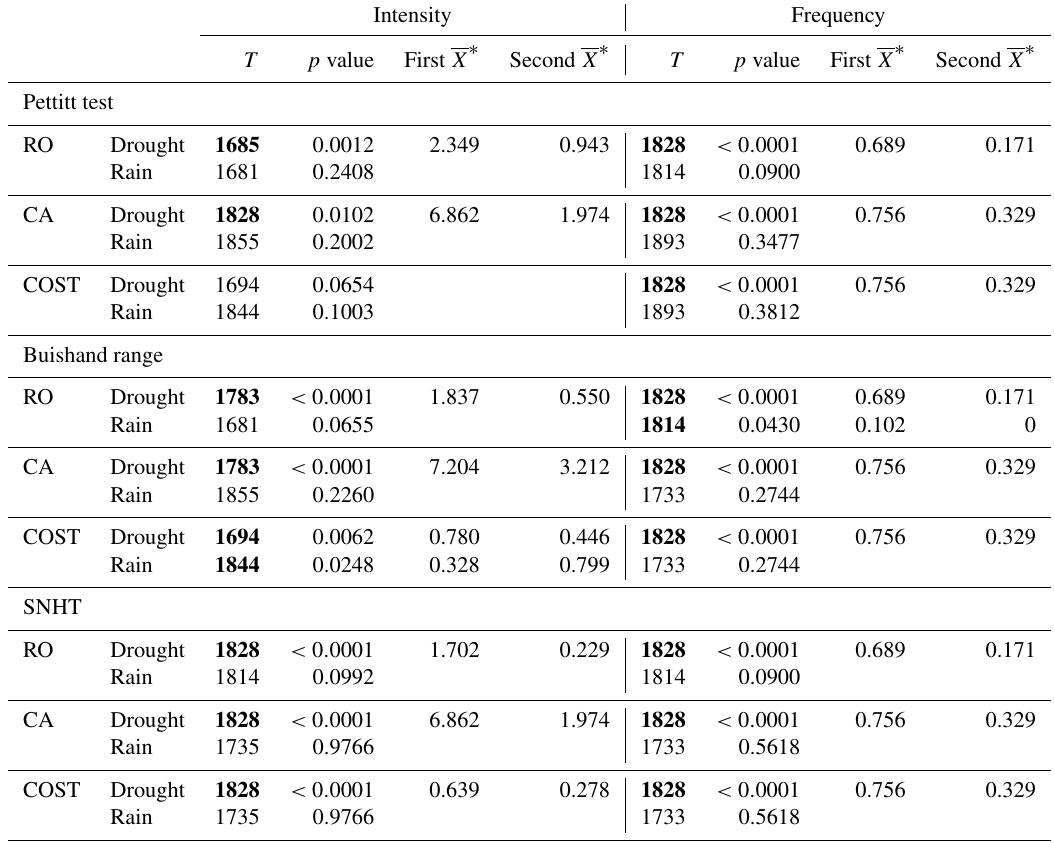
Table 3. Results of the homogenisation tests for breakpoint detection. T refers to the year in which a lack of data homogeneity is detected. To calculate the p value, 10000 Monte Carlo simulations were run. The years when the p value is below the α = 0.05 level of confidence are highlighted in bold. ∗ The first X refers to the average over the period prior the breakpoint, while the second X corresponds to the average for the period after